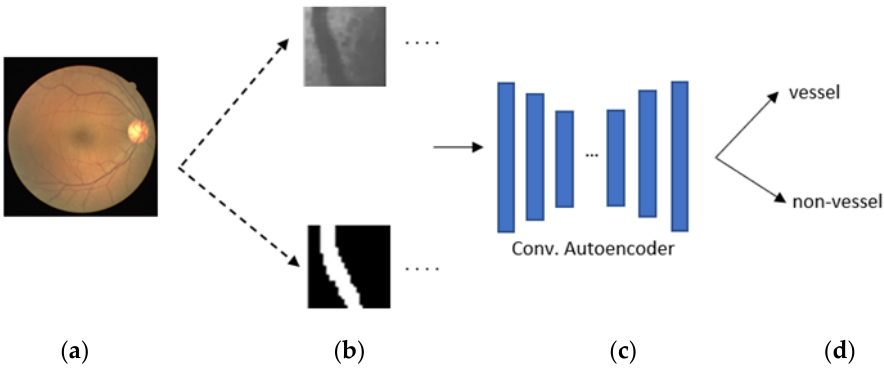
Figure 4. The training process: ( a ) Original image; ( b ) Random cropped patches with the corresponding cropped manual segmentation for the Supervised training; ( c ) Snapshot of the proposed autoencoder; ( d ) Classification of the image pixels.